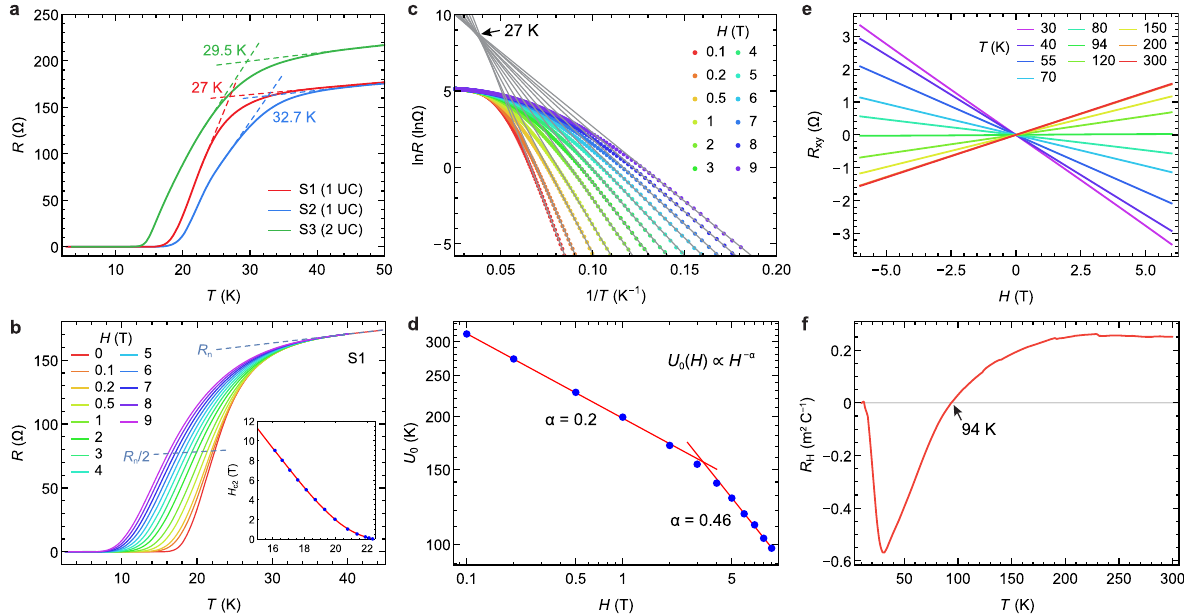
Fig. 3 Transport results of FeSe/ETO. a Temperature dependence of the resistance for three samples with 10-UC FeTe capping layers. The superconducting onset temperatures are marked. b R – T curves of sample S1 in various fi elds with H ‖ c. The inset shows the upper critical fi eld T ) (blue dots) and the fi tting with the Ginzburg – Landau model for multigap superconductors (red line). c Arrhenius plot for the resistance H c2 ( in various fi elds for S1. The corresponding solid lines are fi tting results from the Arrhenius relation. d Field dependence of U 0 (blue dots) derived from the fi tting in panel c, plotted in log – log scale. The red lines are power-law fi ttings for the data below and above 3 T, respectively, possessing different exponents. e Hall resistance R xy ( H ) of S1 at various temperatures. f Temperature dependence of the Hall coef fi cient obtained as [ R xy (6 T) − R xy ( − 6 T)]/12 T, showing a sign change at 94